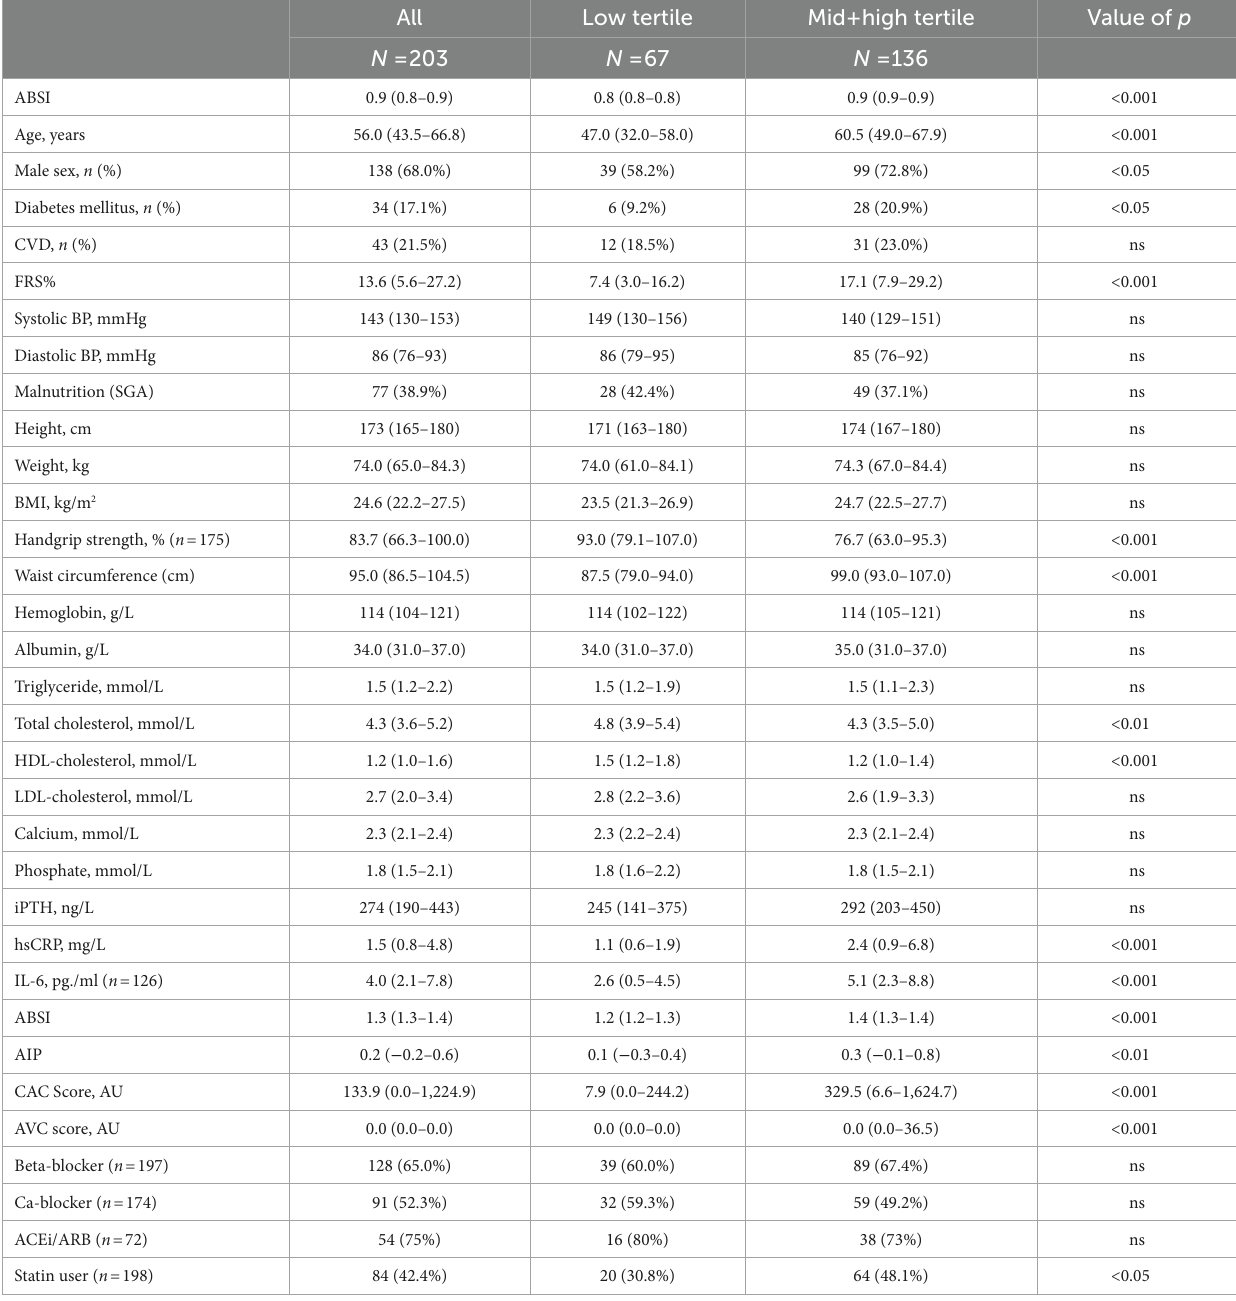
TABLE 2 Baseline clinical and biochemical characteristics of 203 CKD5 patients according to tertiles of a body shape index (ABSI). All Low tertile Mid + high